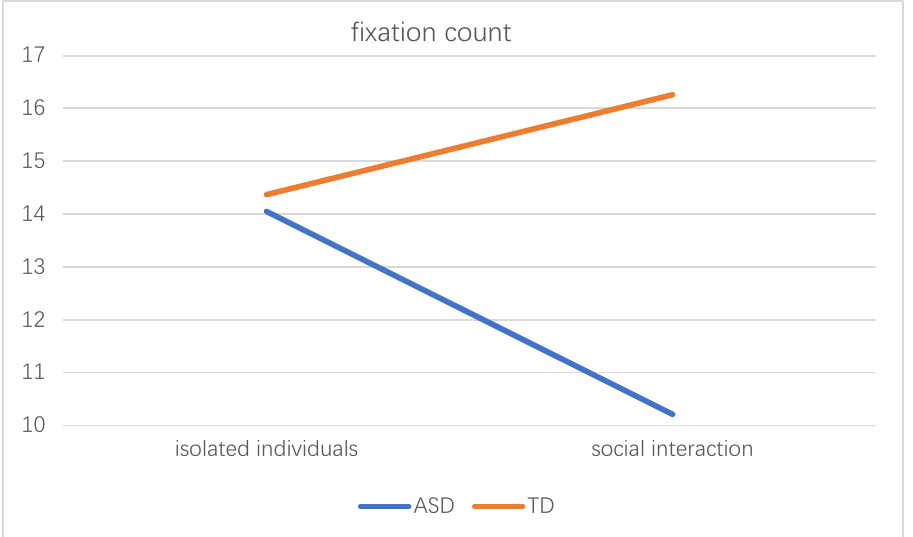
Figure 4. The interaction diagram of the subject category and the scene.